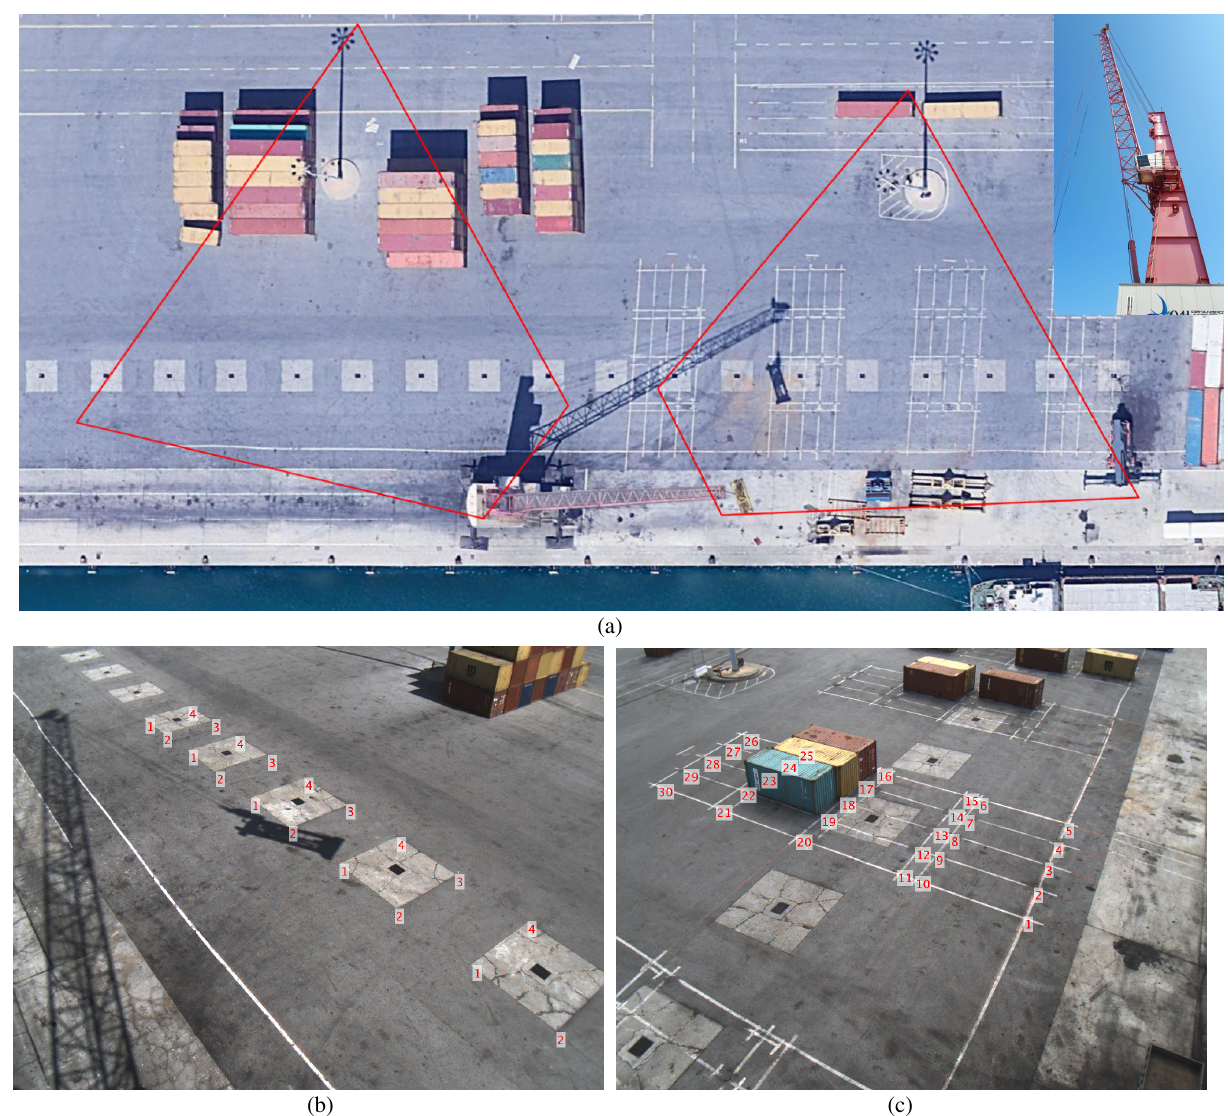
Figure 3. (a) Non-orthorectified satellite view of the port quay with the crane in the bottom middle and the inset image. The two red quadrangles correspond to the intersections of the quay’s plane with the camera frustums of the images in (b) and (c) [the position of the crane shown in image (a) does not coincide with that from which images (b), (c) were taken] . (b), (c) Views of the quay from the camera installed on the crane. The image in (c) was obtained from the reference location and has the employed GCPs superimposed. The four extremal junctions used for the world to image homography estimation are GCPs 1, 5, 26 and 30. Image (b) is a view from the camera after the crane has rotated about 120 ◦ in a counterclockwise direction. The GCPs shown are used for pose